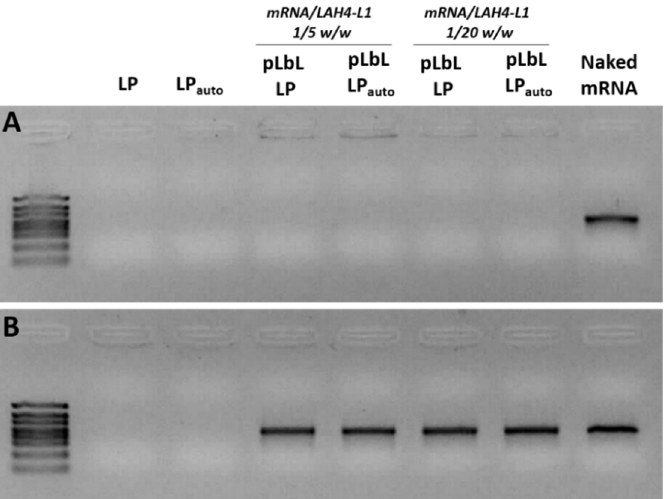
Figure 3. Agarose gel electrophoresis assays of pLbL formulations ( A ) without and ( B ) with mRNA desorption treatment. The concentration of Fluc mRNA was 10 µg/mL.